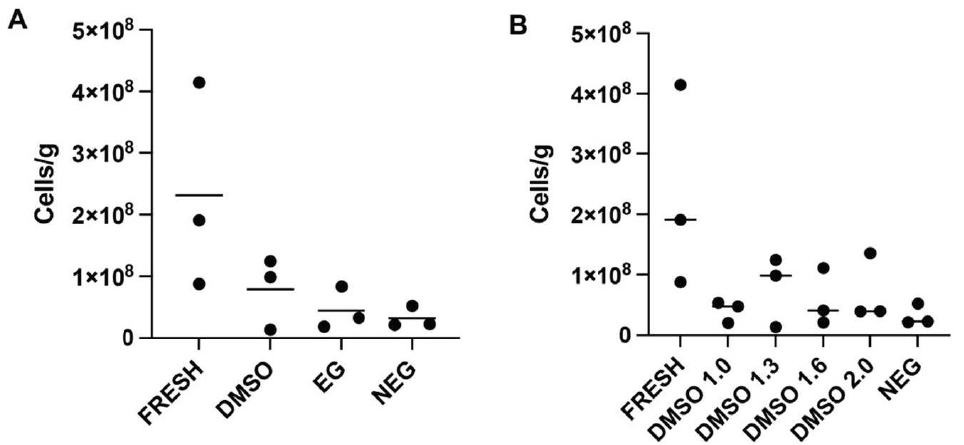
Figure A1. The number of cells recovered per gram of tissue was calculated for each treatment, ( A ) fresh tissue, tissue cryopreserved with DMSO and Ethylene Glycol (EG), and tissue cryopreserved in cryomedium with no permeating cryoprotectant (NEG), as well as ( B ) different concentrations of DMSO from 1.0 M to 2.0 M. No significant difference was reported in cells/g between treatment groups in graph “A” ( p = 0.0905), and “B” ( p = 0.0798; One-way ANOVA with Tukey’s post hoc test).